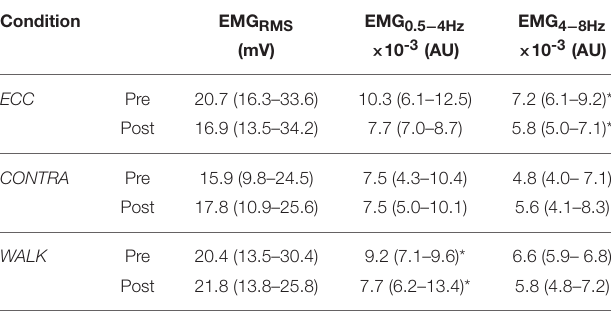
TABLE 2 | Summary of EMG variables for soleus.